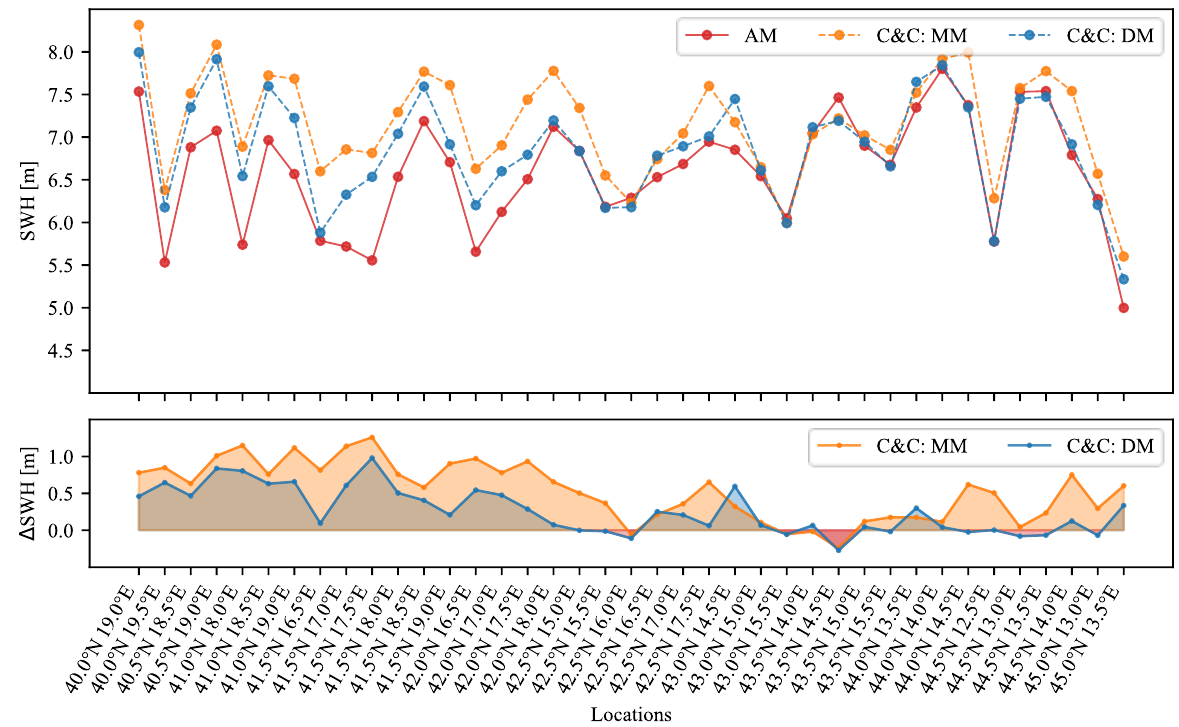
Figure 5. The extreme SWHs for the return period of 100 years. The blue dashed line represents long-term predictions calculated using system probability distribution obtained by the C–C method combining probability distributions of DM. The orange dashed line combines distributions of MM. The red line represents the conventional method using AM, neglecting both effects. Moving from left to right on the horizontal axis corresponds to moving across locations from southeast to